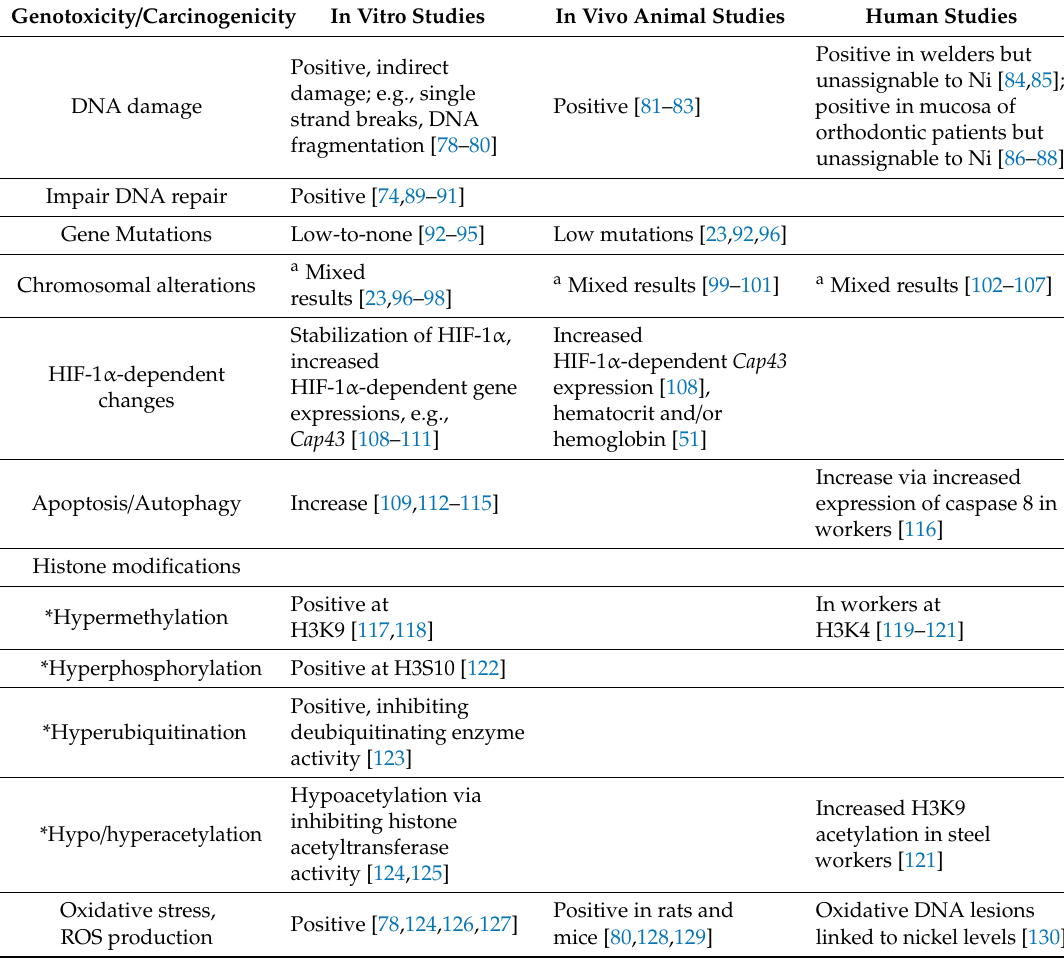
Table 1. Summary of genotoxicity evidence of nickel and nickel compounds in vitro, in vivo and in